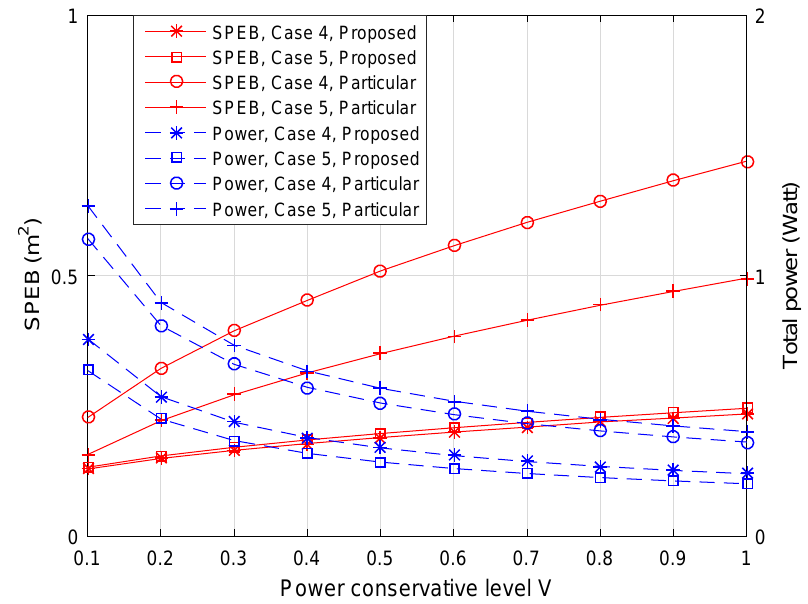
Figure 10. The average SPEB of agent nodes and total power consumption of anchor nodes with respect to different anchor-specific power conservation levels V